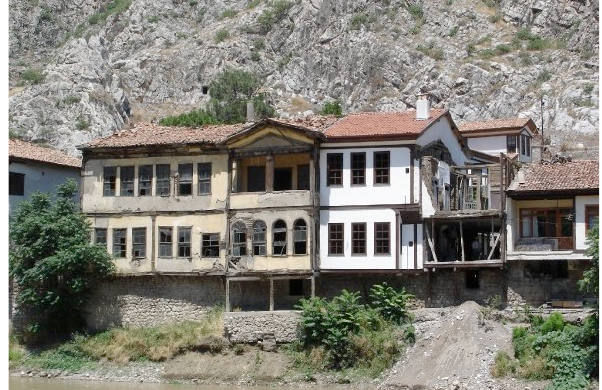
Figure 3. Yorguc Pasa Mansion before